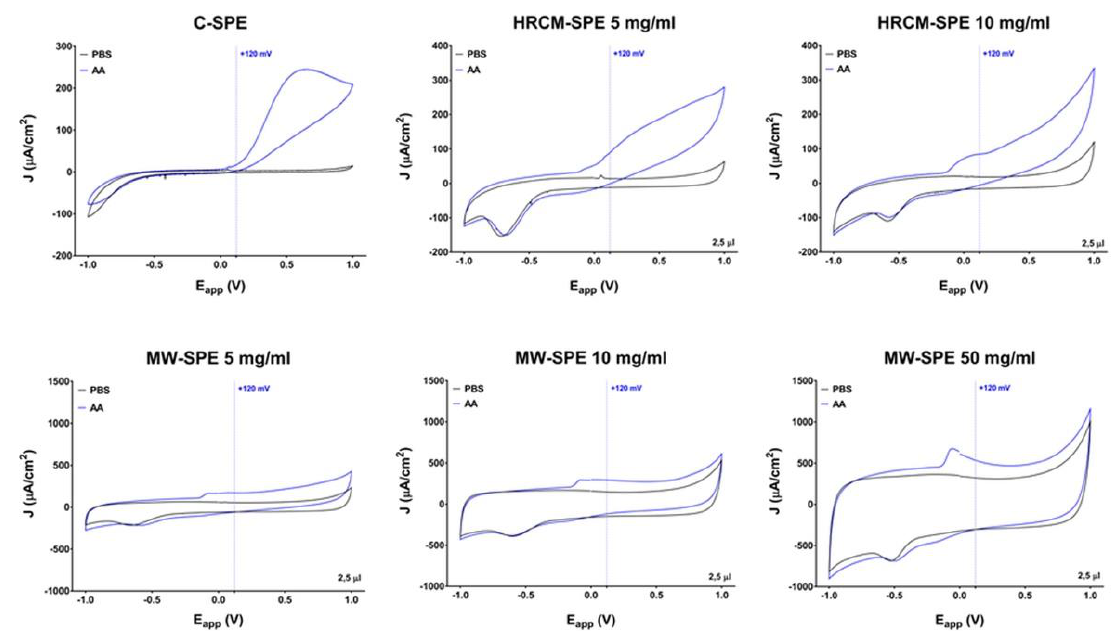
Figure 3. AA cyclic voltammograms with a scanned potential range (E app ) between -1 and +1 V vs. Ag/AgCl pseudo-RE in the absence (black line) and in the presence of 2 mM AA (blue line). Cyclic voltammetries were performed with the C-SPE, HRCM-SPEs (functionalized with 5 and 10 mg/mL HRCM/DMF), and MW-SPEs (functionalized with 5, 10, and 50 mg/mL MWCNTs/DMF).